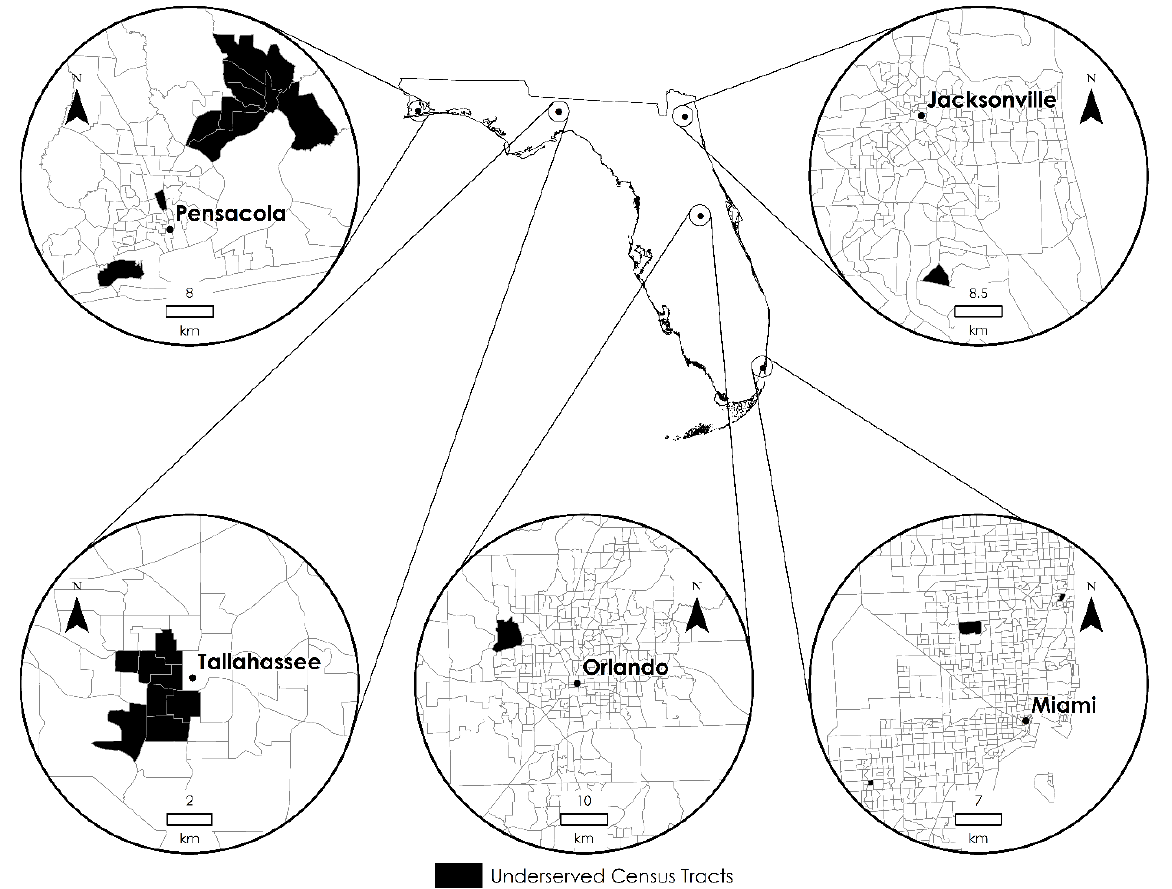
Figure 6. Underserved census tracts in urban areas according to the eRFEI. There are ten census tracts in Pensacola, eight in Tallahassee, one in Jacksonville, one in Orlando, and three Miami.